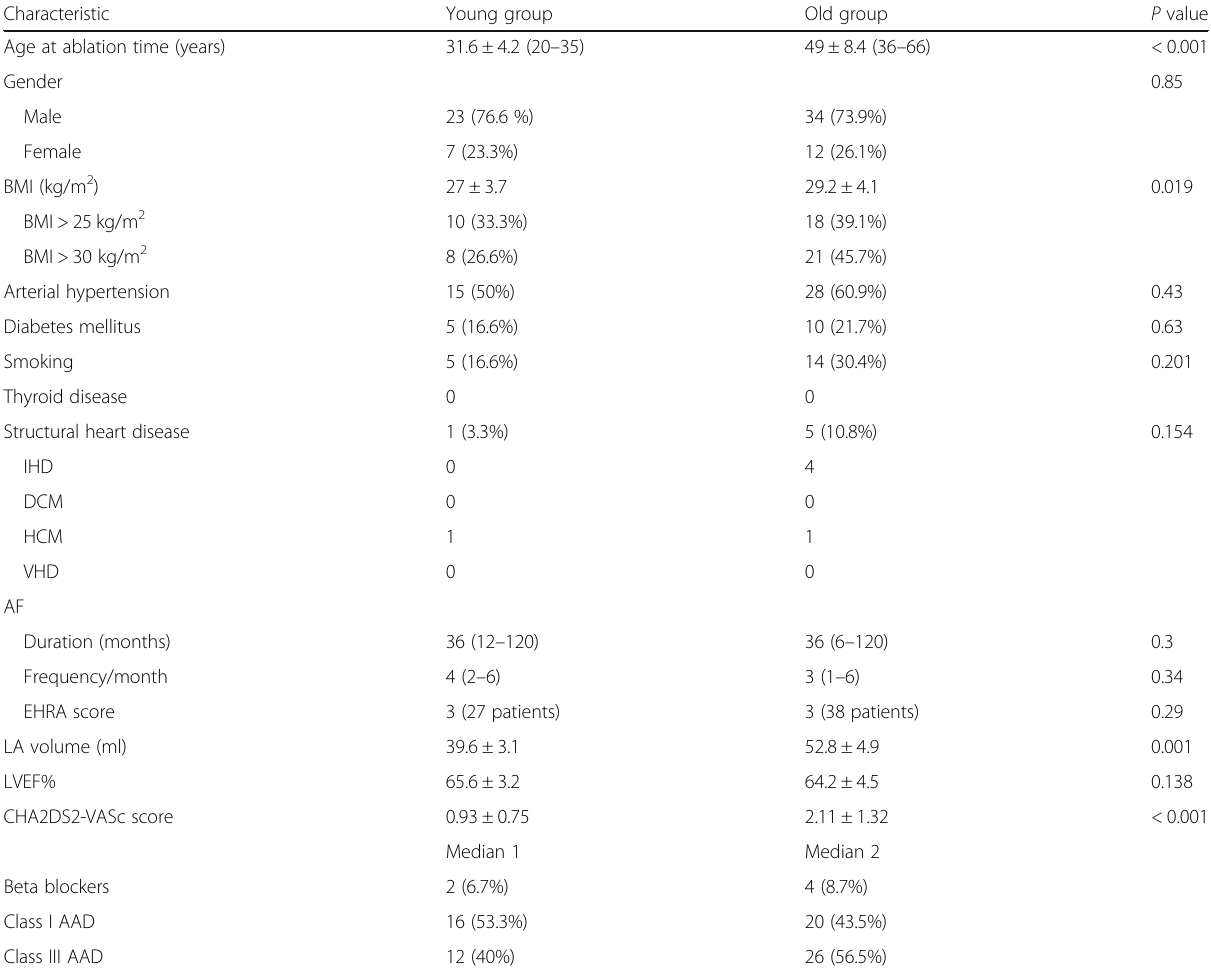
Table 1 Baseline clinical characteristics of the study groups Characteristic Young group